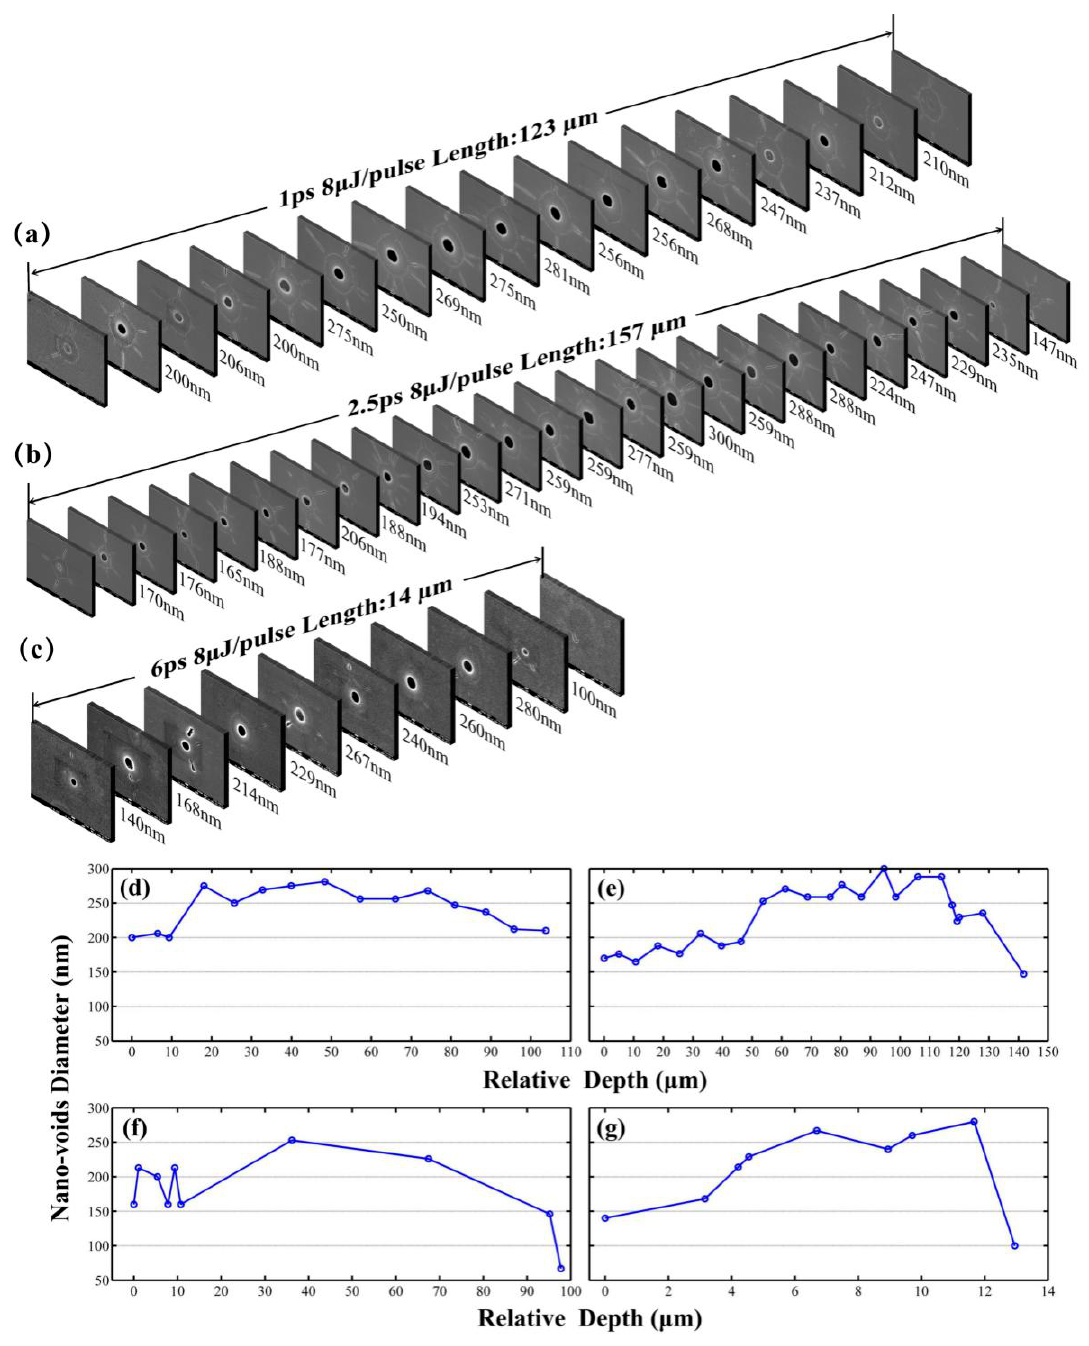
Figure 3. Tomography of the hole drilled by a single ultrafast Bessel beam pulse. Pulse energy keeps constant at 8 μ J/pulse. Different pulse durations are used, shown in ( a – c ). Corresponding curves of nano-holes diameter and relative depth are given above, where ( d ), ( e ), ( f ) and ( g ) represent curves for 1 ps, 2.5 ps, 4 ps and 6 ps cases respectively. Take the position of the first hole as zero relative depth.